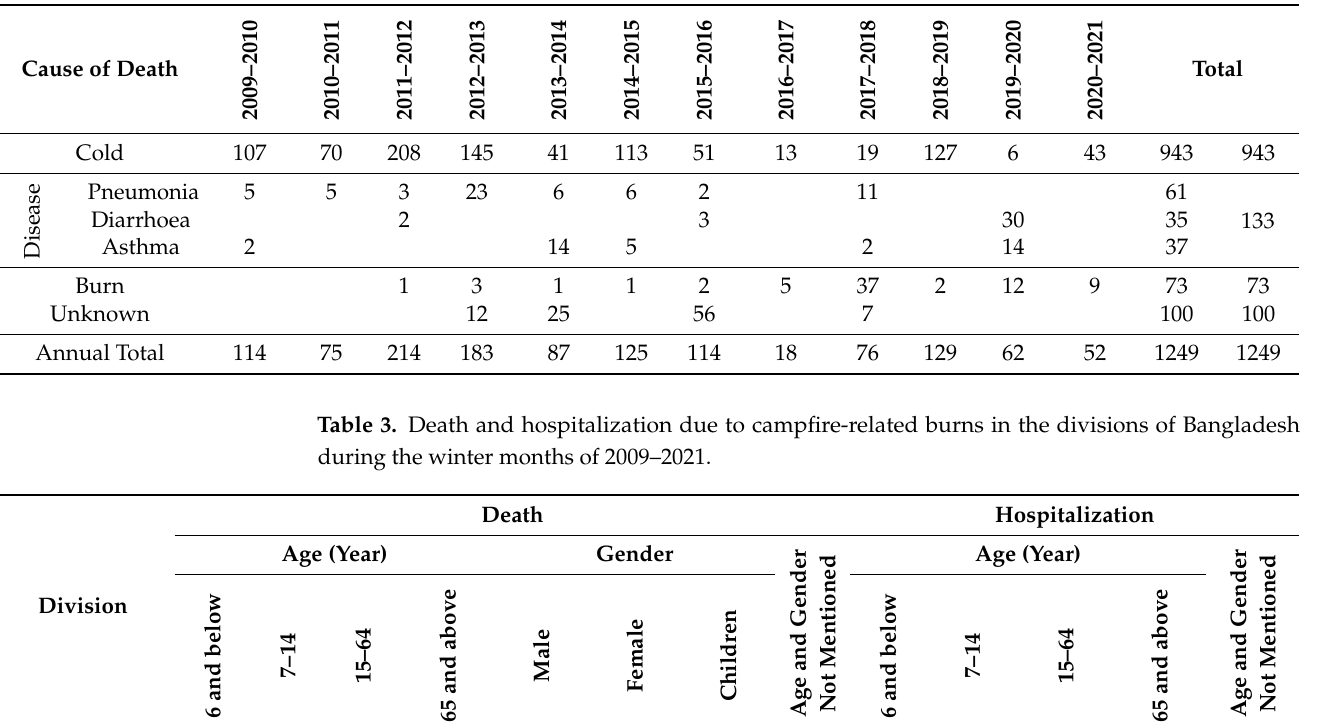
Table 2. Causes of death during the winter months of 2009–2021.